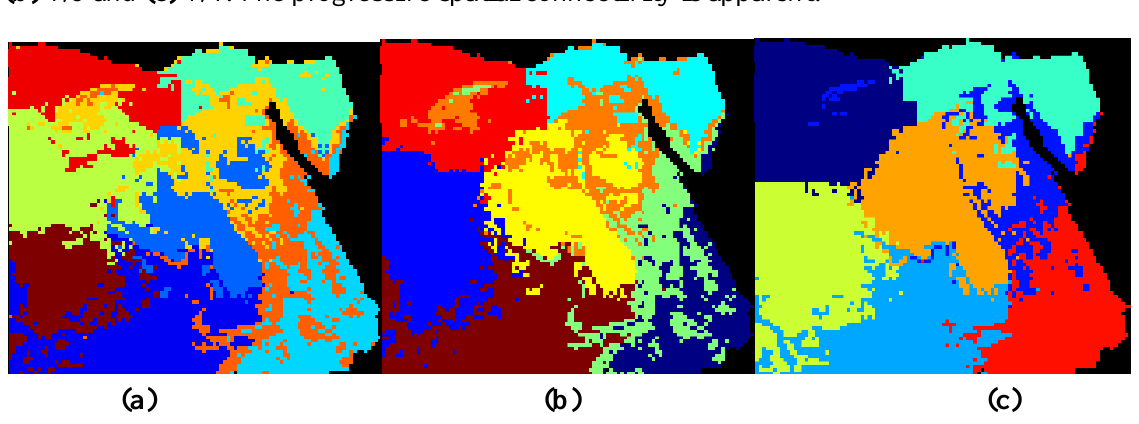
Figure 6. Spatially fused clustering with gradually ascending spatial weights (a)